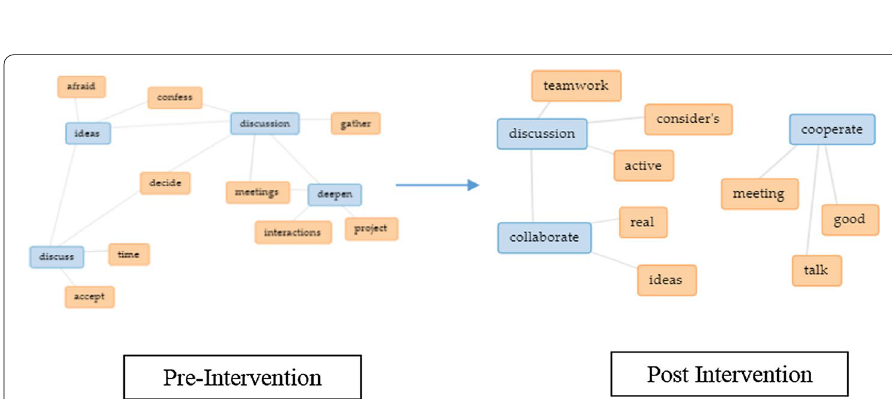
Fig. 14 Changes in perception for the CT group based on recommendations for learning improvement as a